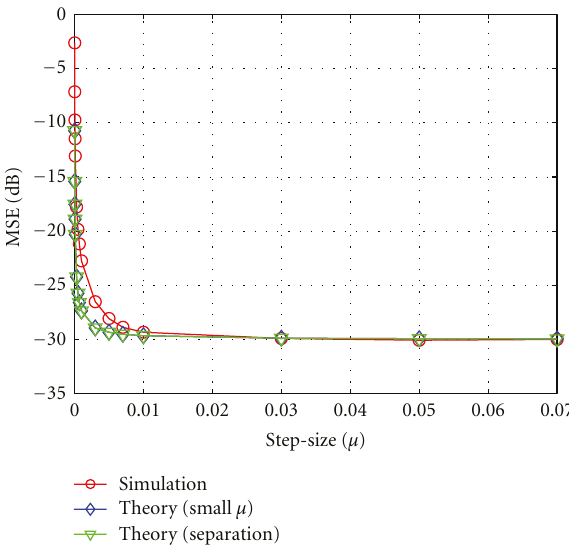
Figure 5: Theoretical and simulated MSE learning curves of the SRLMF algorithm for a random-walk channel with SNR = 30 dB.